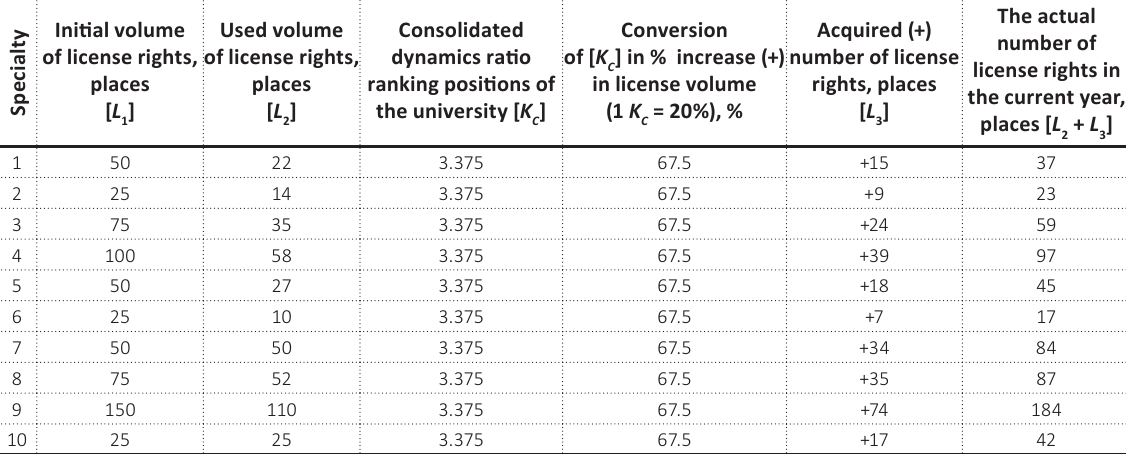
Table 3. Licensed volumes of admission to the specialties of the university No. 3 in the current year (bachelor’s